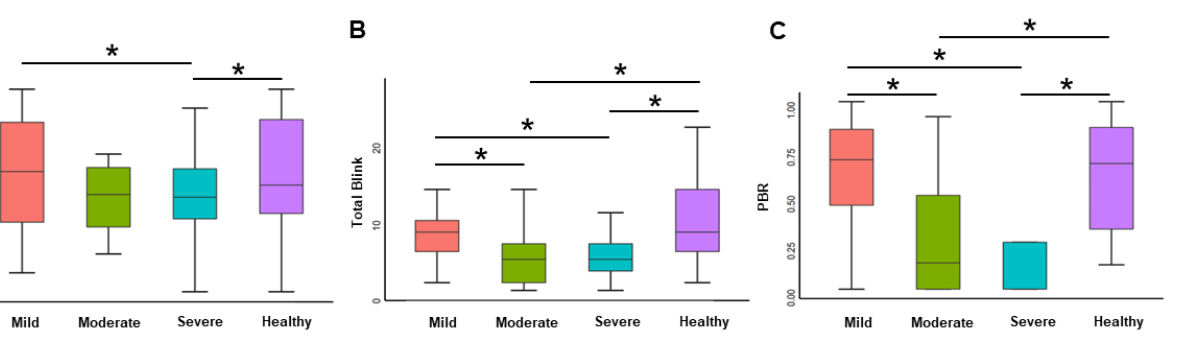
Figure 1. Characteristics of LLT ( A ), total blink ( B ), and partial blink rate ( C ) of subjects. (* p < 0.05)